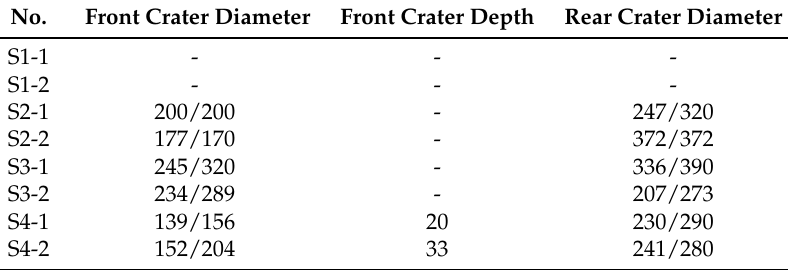
Table 4. Blast damage for plain and fiber-reinforced concrete panels (in mm).